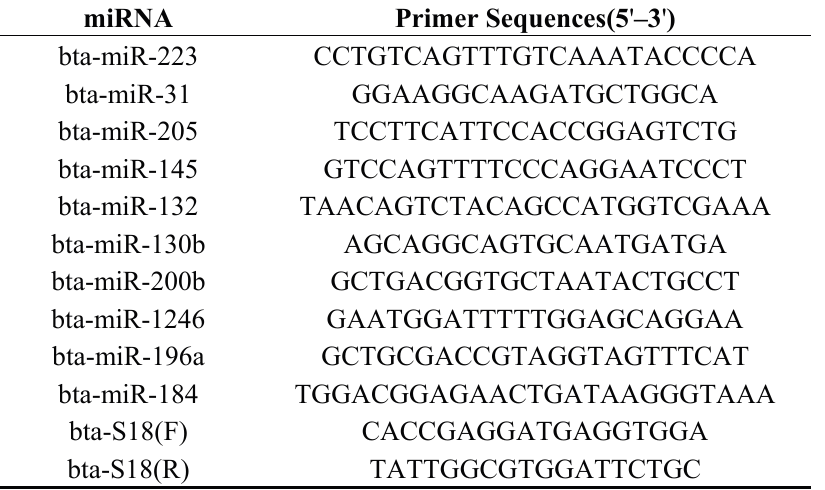
Table 4. Primer sequences for real-time